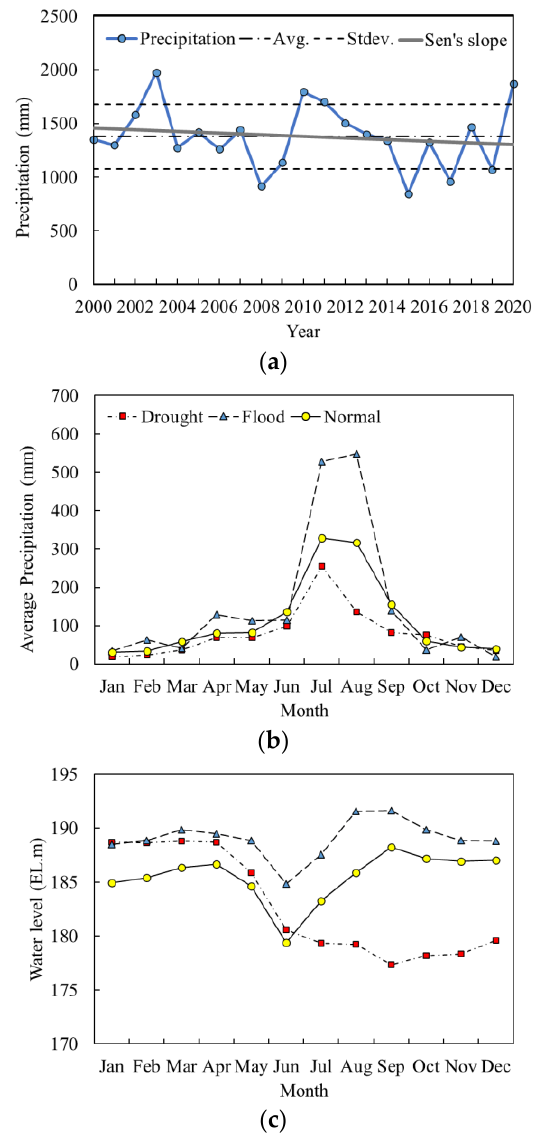
Figure 2. Temporal variations of key hydrological parameters. ( a ) Inter-annual variation of total annual precipitation, and monthly variation of ( b ) precipitation and ( c ) water levels of the Okjeong Reservoir in the drought, flood, and normal precipitation years.